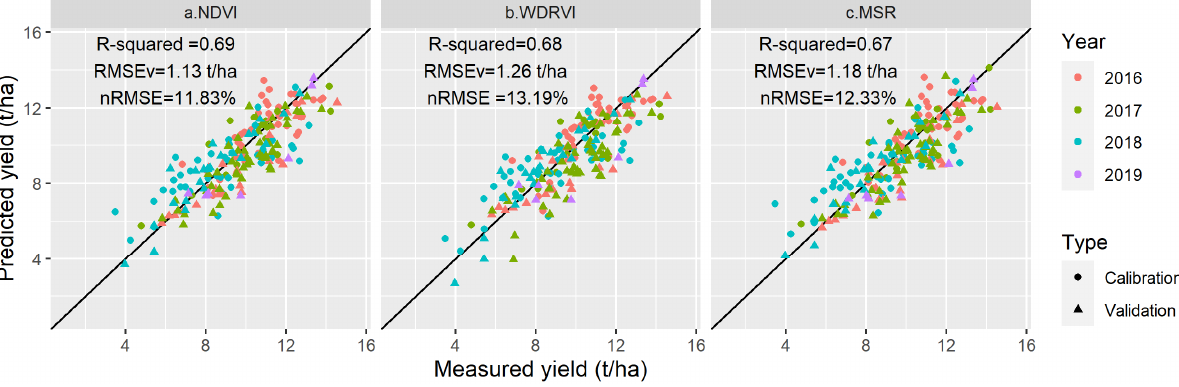
Figure 4. Relationships between measured and predicted yield under the MLR model using ( a ) NDVI, ( b ) WDRVI, and ( c ) MSR.